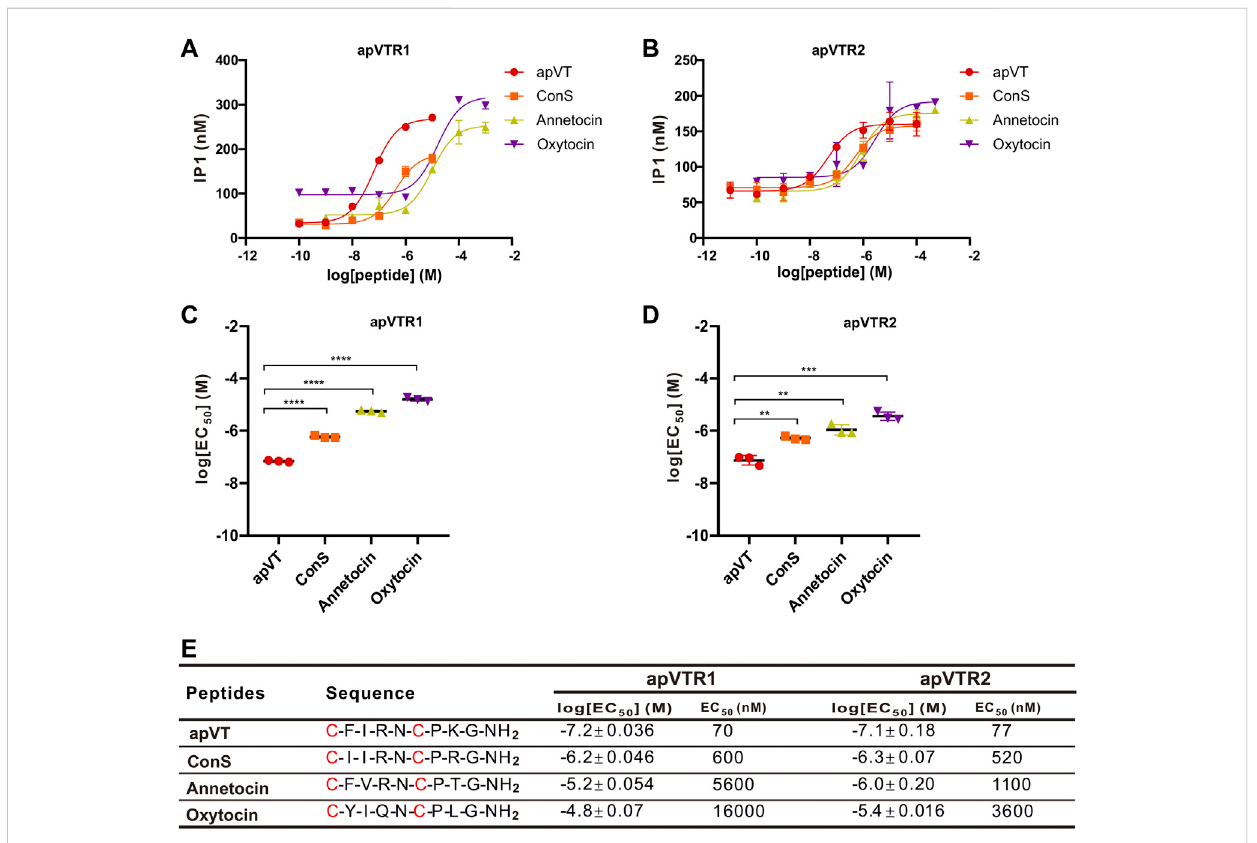
FIGURE 9 Activation of apVTRs by vasopressin/oxytocin-like peptides from other species. (A) Activation of apVTR1 by vasopressin/oxytocin-like peptides: ConS, annetocin, and oxytocin; apVT was used as a control. (B) Activation of apVTR2 by vasopressin/oxytocin-like peptide: ConS, annetocin, oxytocin; apVT was used as a control. (C) Comparison of log[EC 50 ] for apVTR1 by the four peptides ( n = 3 for each) shown in (A) . One-way ANOVA, F (3, 8) = 1,158, p < 0.0001. (D) Comparison oflog[EC 50 ]for apVTR2bythefourpeptides( n =3for each) shownin (B) .One-way ANOVA, F(3,8) =58.27, p <